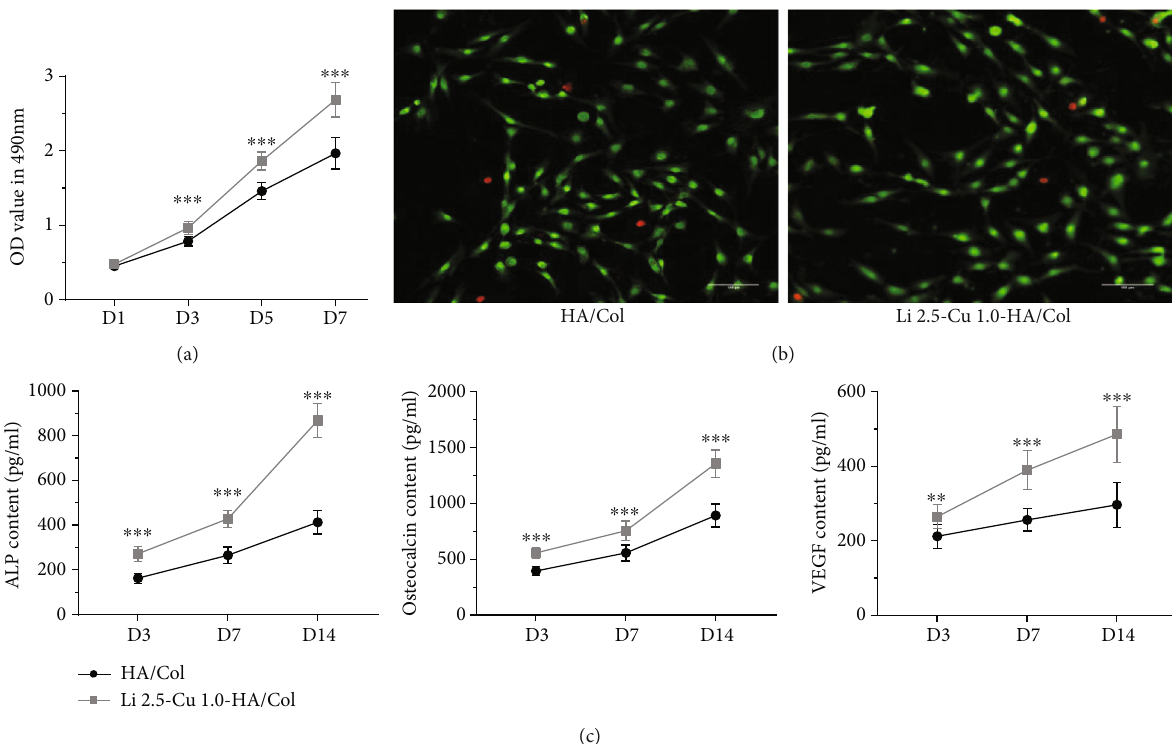
Figure 3: Li 2.5-Cu 1.0-HA/Col sca ff old has good biocompatibility and could promote the secretion of osteogenesis and angiogenesis factors. (a, b) The proliferation and vitality of BMSC coculture with Li 2.5-Cu 1.0-HA/Col sca ff olds tested by the MTS assay (days 1, 3, 5, and 7) and Live-Dead Cell staining (day 3). (c) ELISA analysis of the secretion of osteogenesis (ALP, OCN) and angiogenesis (VEGF) factors when BMSCs were cocultured with Li 2.5-Cu 1.0-HA/Col sca ff